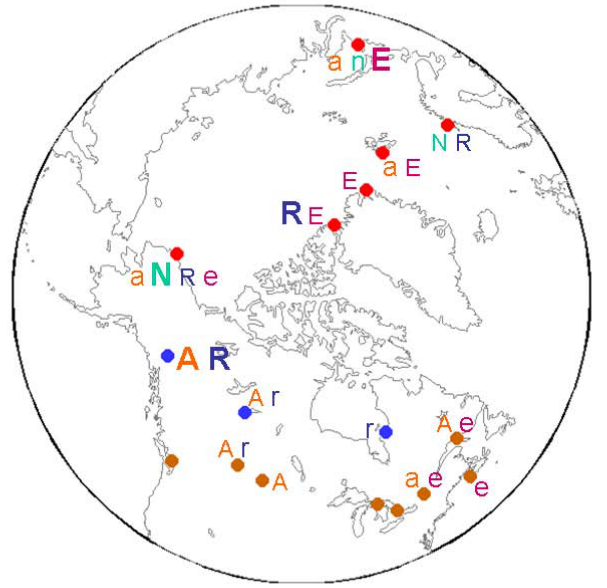
Fig. 7. This figure provides a visual representation of Table 4. Sta- tions receiving the maximum, at least the 75th percentile, and at least the median but less than the 75th percentile number of events from a given source region are assigned, respectively, a large upper- case letter, an upper-case letter, and a lower-case letter denoting the source region.